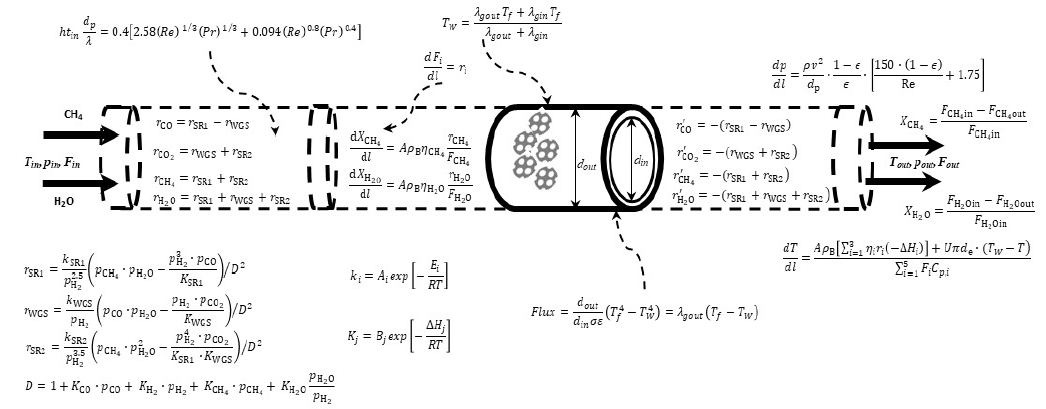
Figure 3. The analytical expressions used in the one-dimensional heterogeneous model according to literature findings [9,10,15–25].